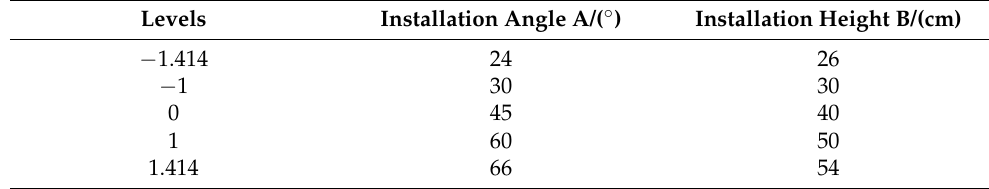
Table 4. Test factor code.